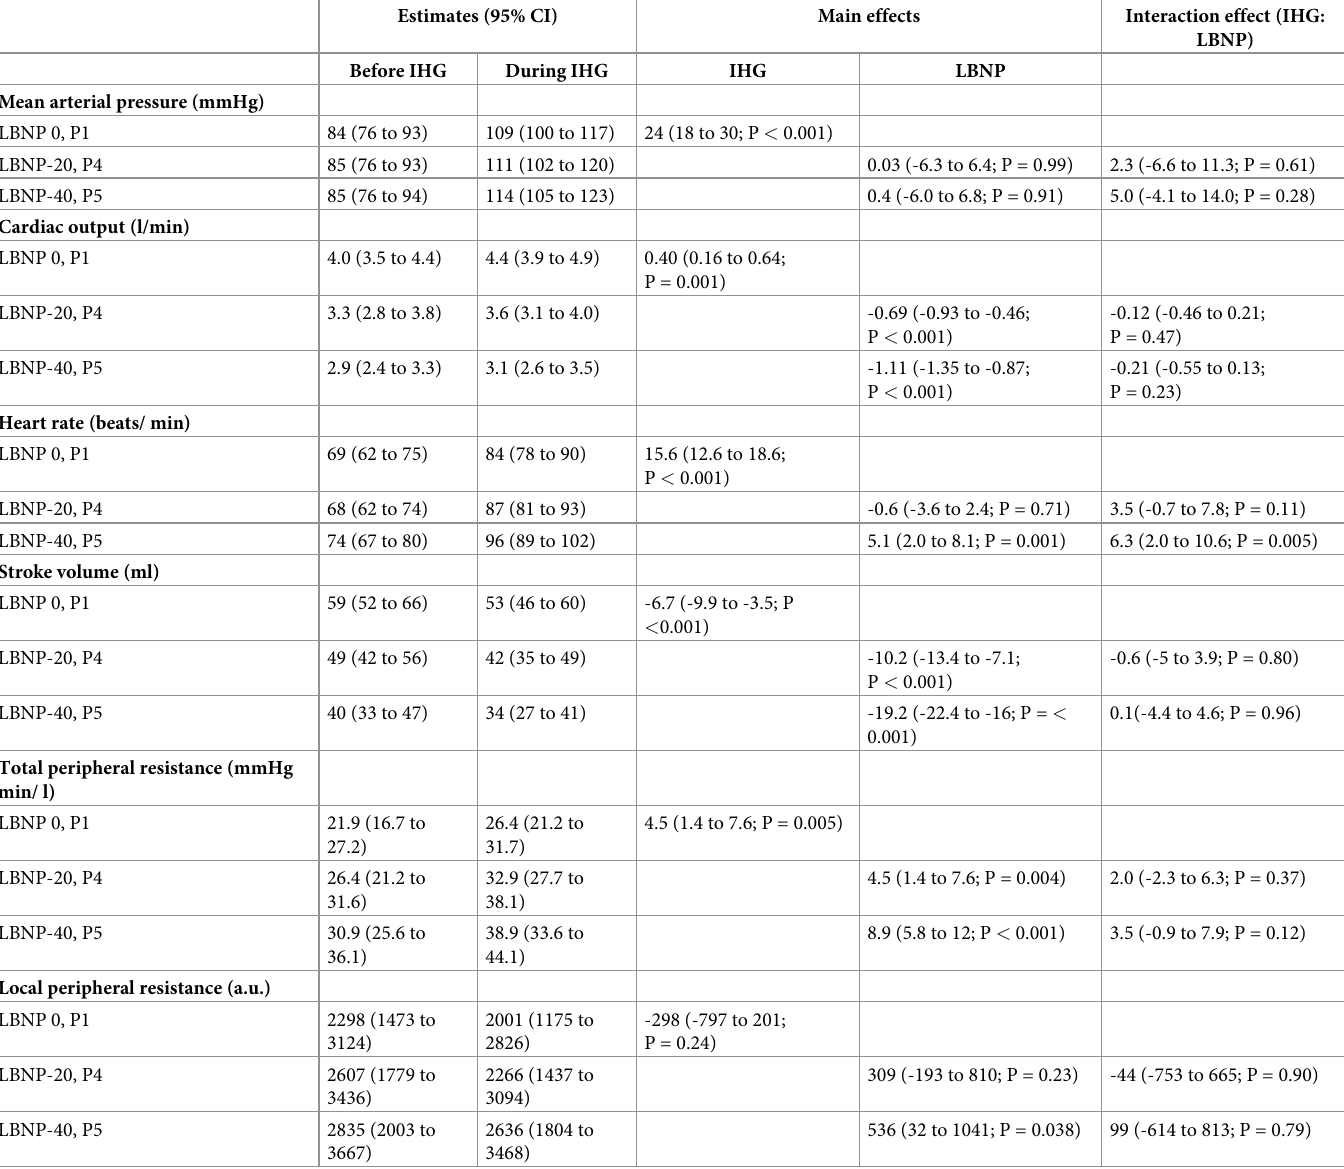
Table 1. Hemodynamic response to IHG during continuous